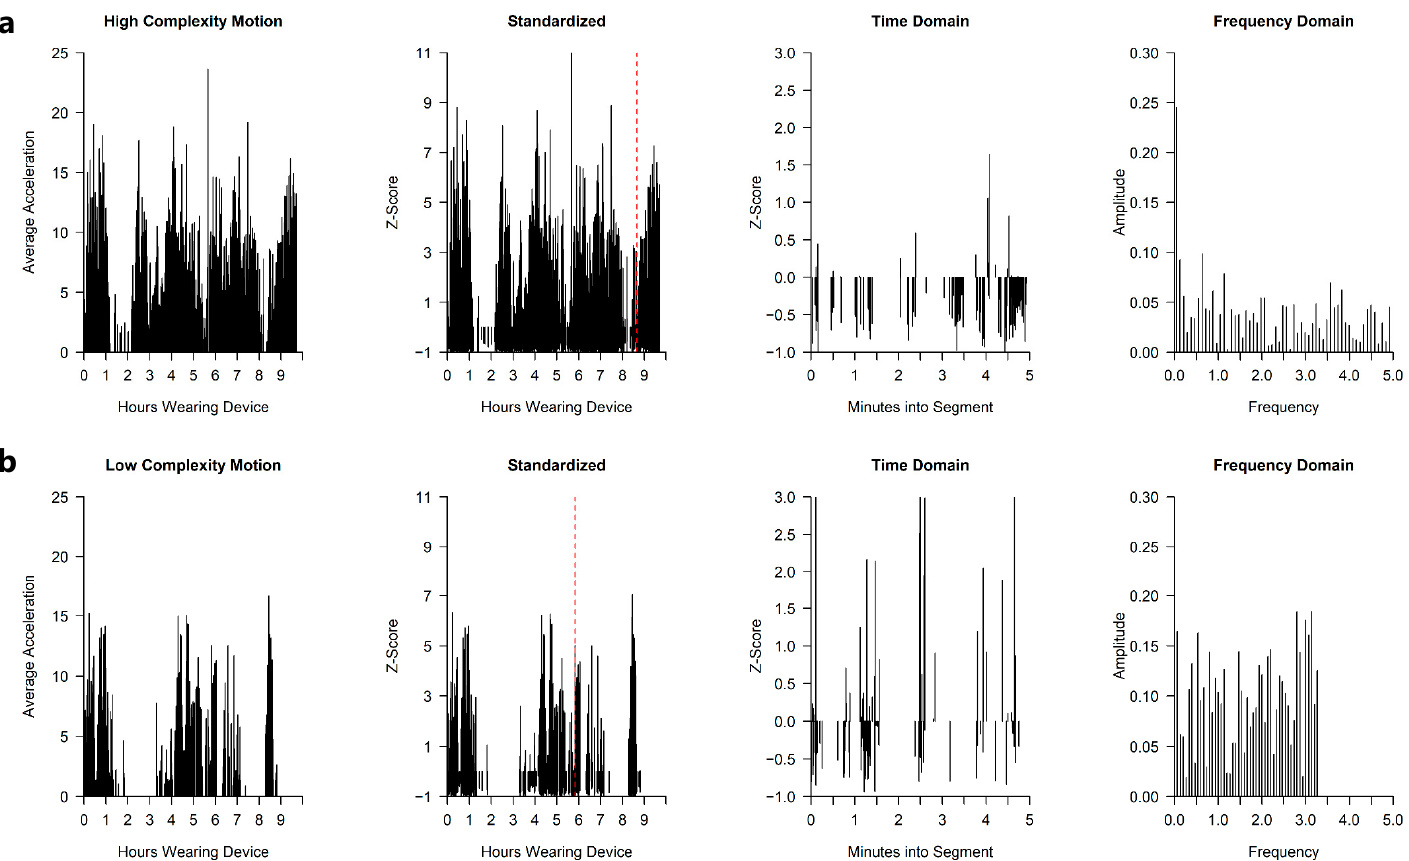
Figure 2. These figures display the steps taken to construct the motion complexity measure. ( a ) depicts an HR infant with high motion complexity, and ( b ) depicts an HR infant with low motion complexity. Column one is the raw, full-day average acceleration data for the left leg. Column two represents the data in column one after the data has been z-scored (overall magnitude and variability of motion are now comparable between both cases). Column three represents a high and low complexity 5-min time segment (indicated by red dashed line in column two). Column four represents the data from column three after it has been translated to the frequency domain. In column four, the components of the high-complexity motion vary more widely in frequency than the components of the low-complexity motion.